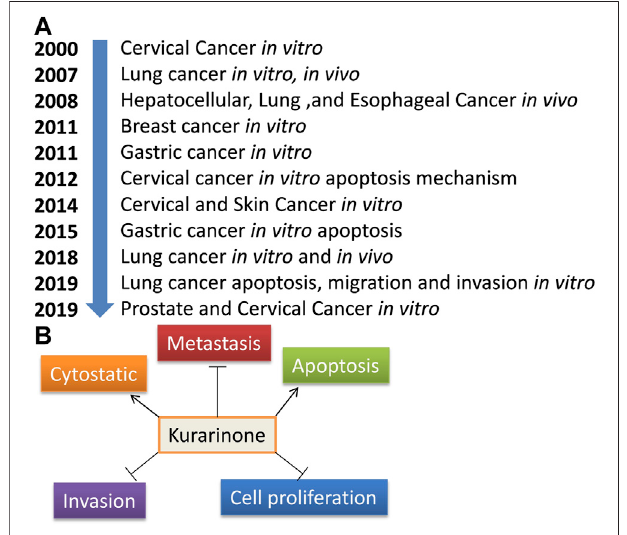
FIGURE 2| Anticancer studies on kurarinone. (A) Year-wise anti-cancer studies on kurarinone, (B) cancer hallmarks target by